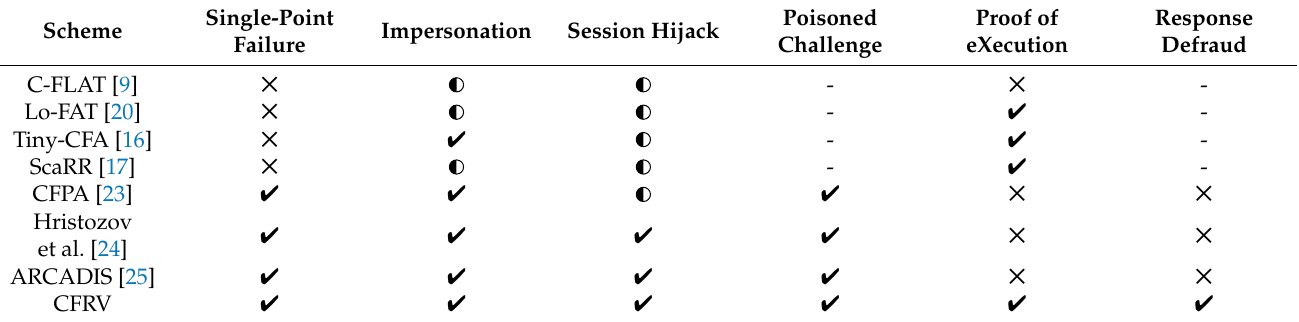
Table 2. Safety analysis of related